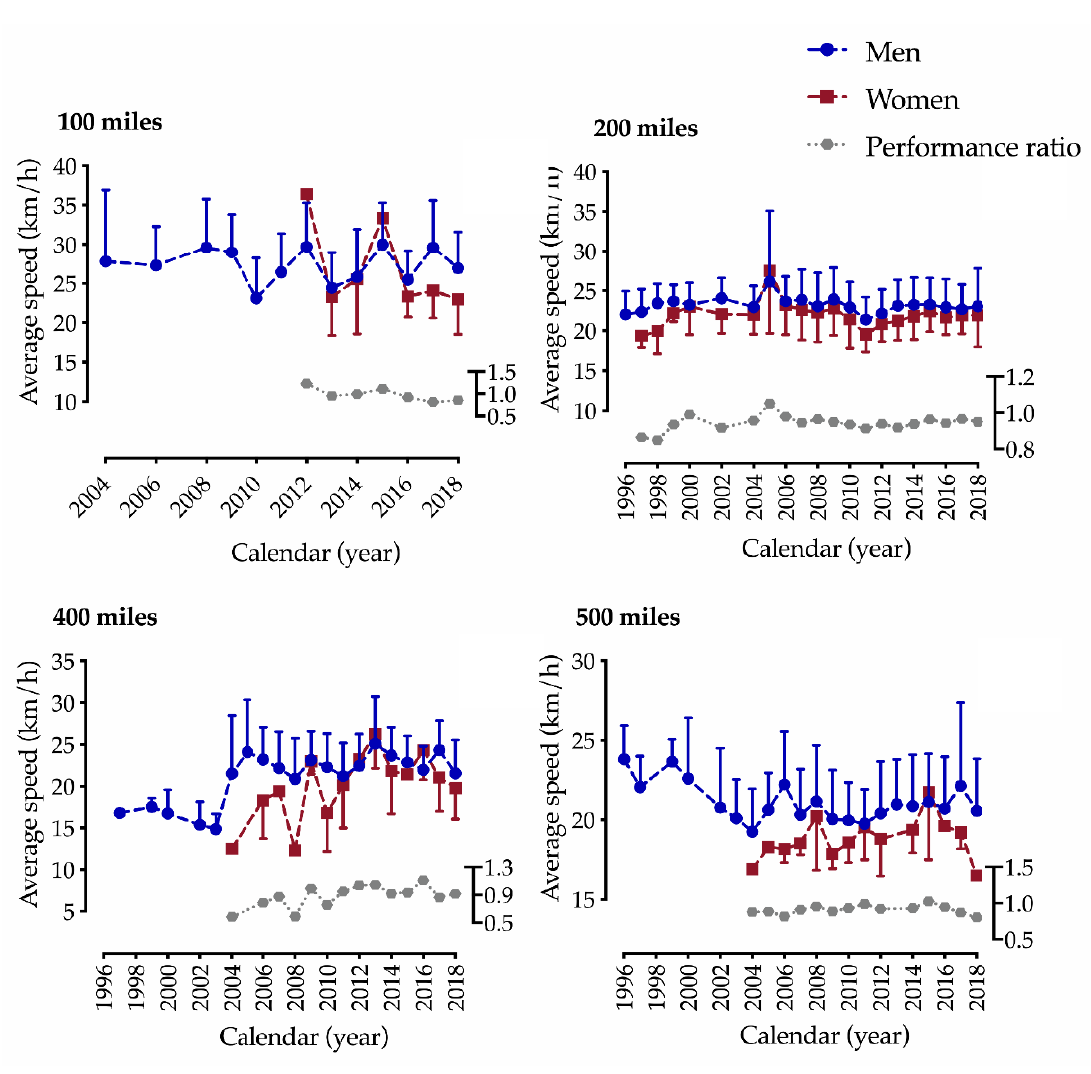
Figure 2. Performance trends of male and female participants in ultra-distance cycling in 100–500 mile races from 1996 to 2018. Data expressed as means and standard deviations.